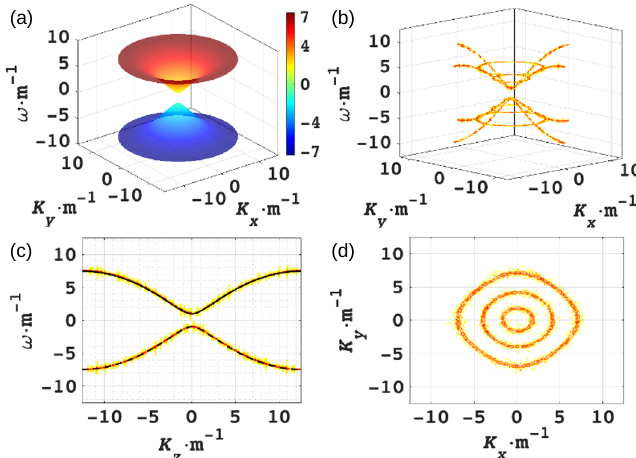
Figure 2 . Numerical dispersion relation of a free fermion. (a) The Dirac double-cone in the BZ of a DEC lattice. Different from the Dirac double-cone in continuous space-time, the exact dispersion relation of the LCFT shown here is modified near the BZ boundary. It can be found that each branch of the spectra has only one cone centered at the origin of BZ. As a result, there are only two degenerate fermion flavors exist. (b) The numerical dispersion relation (contour slice) on k z = 0 plane. (c) The numerical dispersion relation (contour plot) along k z axis. These free fermion dispersion relations are obtained by a real-time LCFT simulation, which show good consistency with the analytical Dirac double-cone of the LCFT (solid line for positive state and dashed line for negative state). The energy gap 2 m between positive and negative states is perfectly recovered. (d) The numerical isoenergic surfaces (contour plot) on k z = 0 plane. ω · m − 1 = 2 , 4 , 6 from the